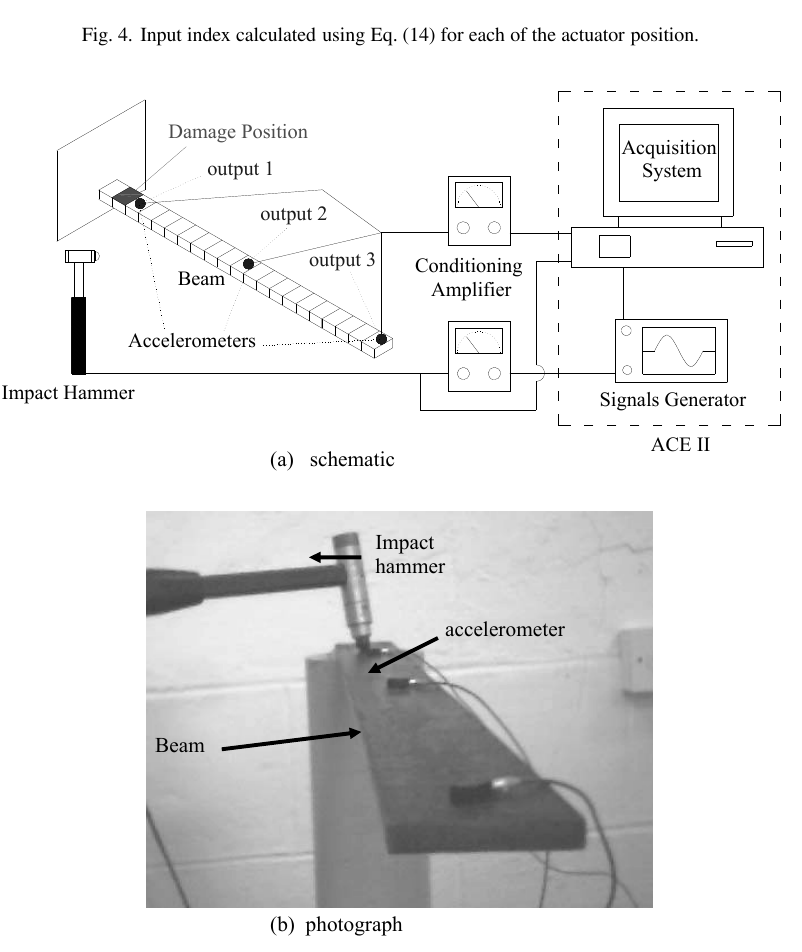
Fig. 5. Experimental setup used for damage location using the observability grammian. (steel cantilever beam with 420 mm long, 37 mm wide and 5 mm thick). fi lter with a cut-off frequency of 1 kHz was used. The parameters of the system were then identi fi ed by using the Eigensystem Realization Algorithm (ERA) described in Section 2. The order of the system was chosen to be equal to six, so, only the fi rst three modes were used to compute the grammian matrices. Damage was simulated by